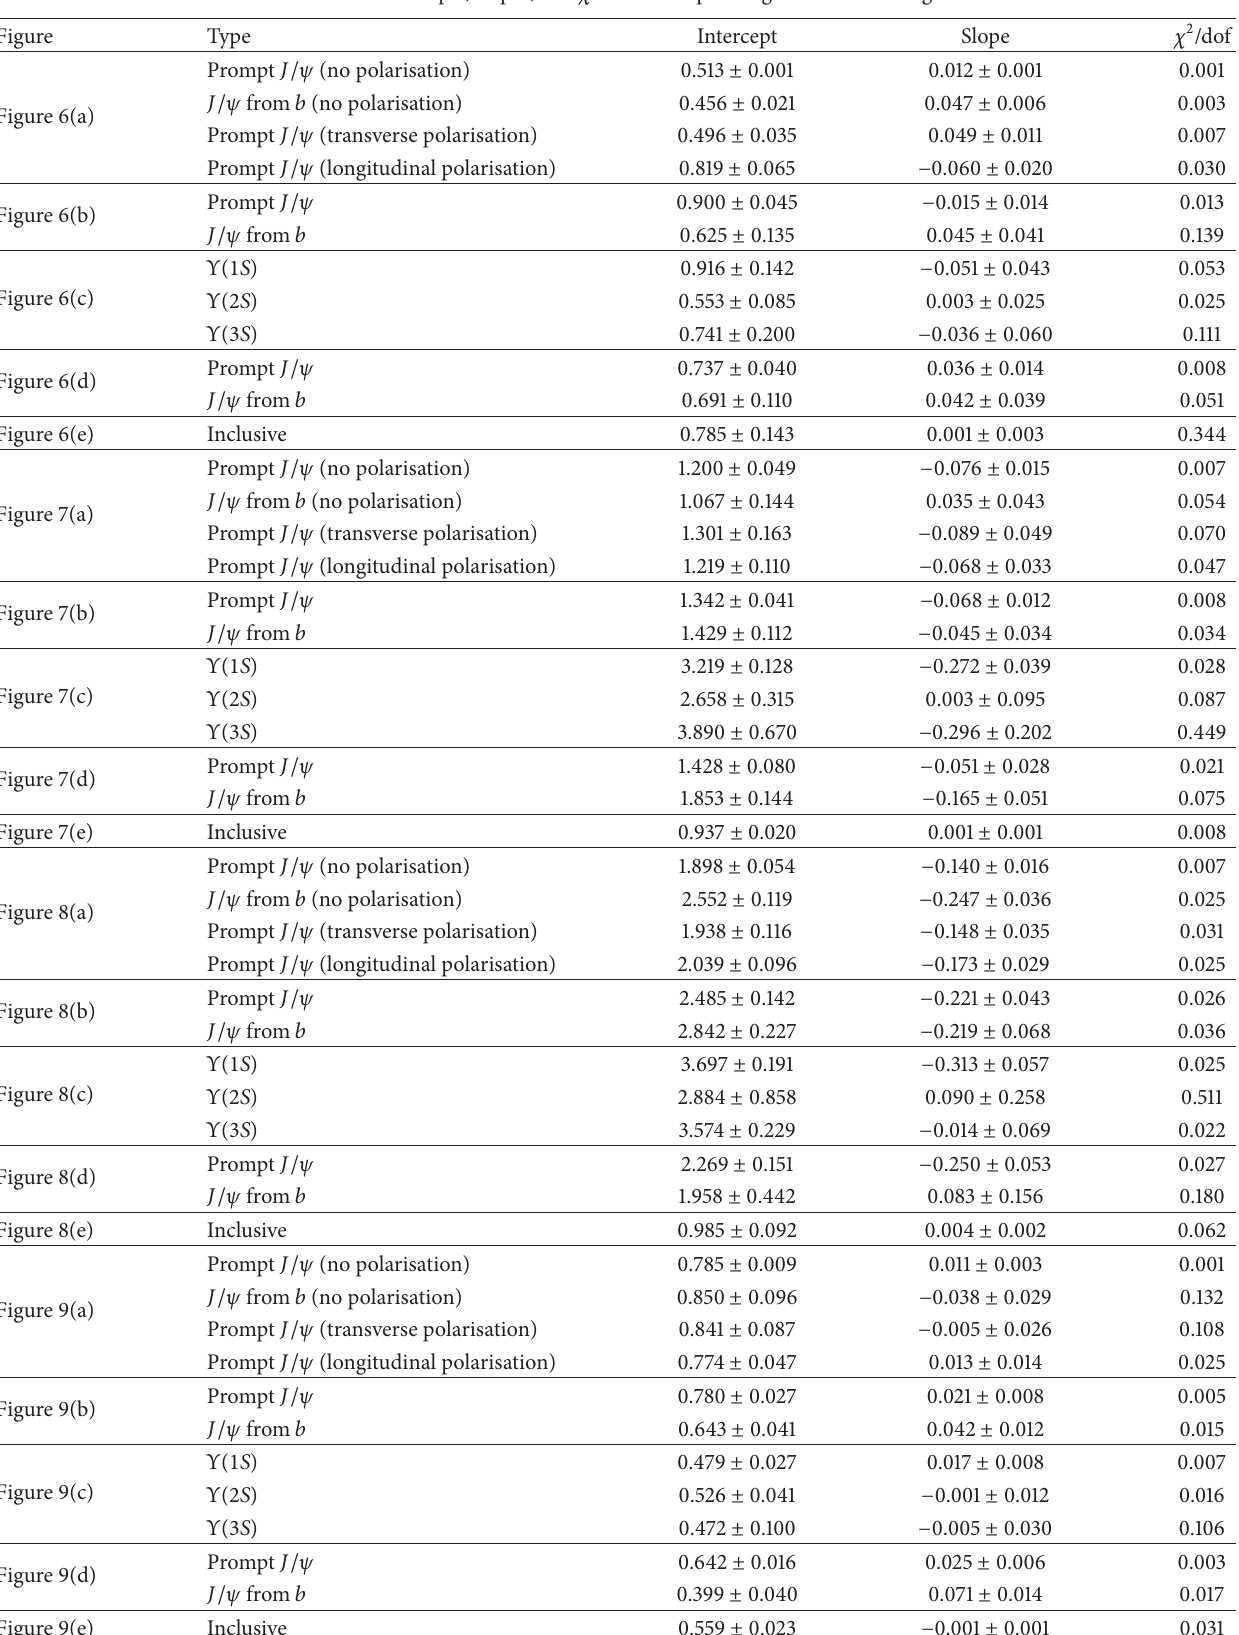
Table 2: Values of intercepts, slopes, and 𝜒 2 /dof corresponding to the lines in Figures